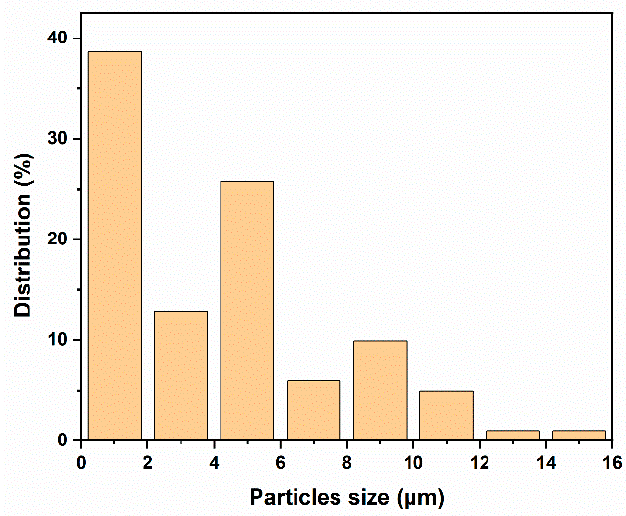
Figure 7. Size distribution of Sm 2 O 3 -APTES powders.